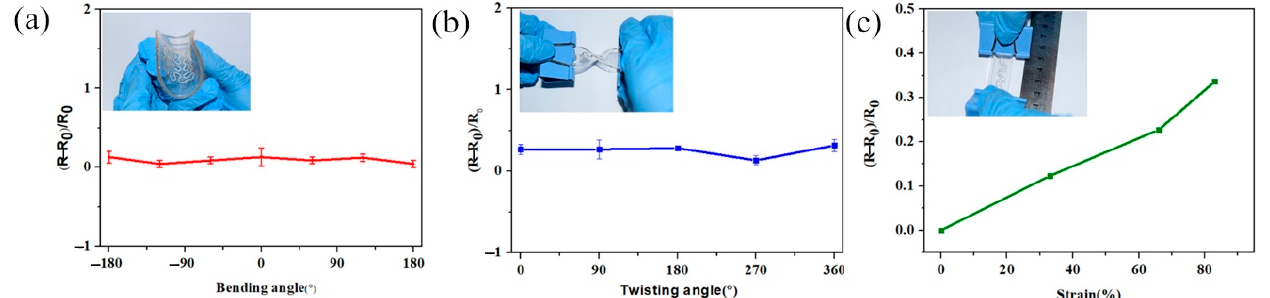
Figure 4. ( a ) Relative resistance changes of the LM circuit under bending. ( b ) Relative resistance changes of the LM circuit under twisting. ( c ) Relative resistance variation curves of the LM wires during tension.